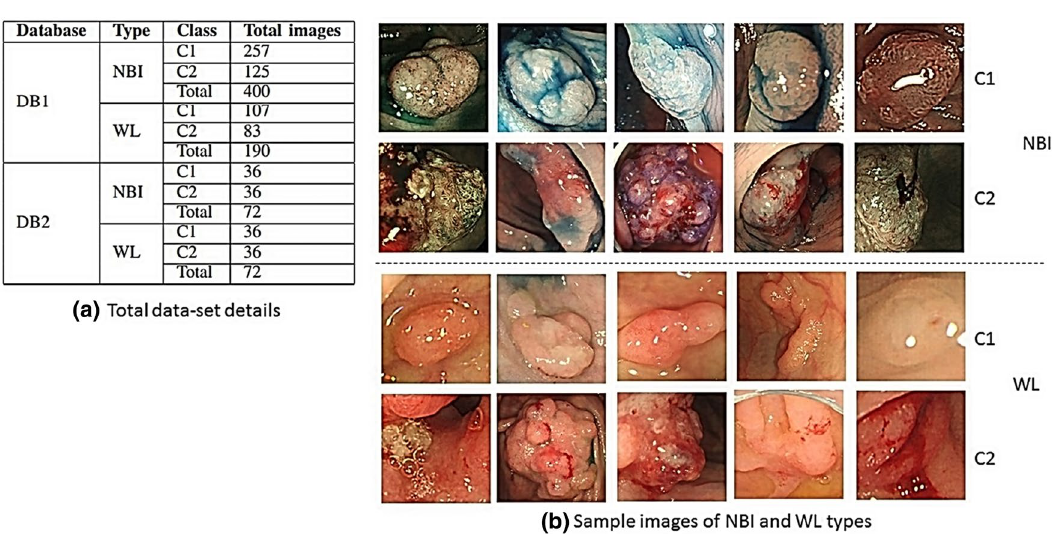
Figure 2. Dataset details with sample images, C1: non-neoplastic samples, C2: neoplastic samples. ( a ) Brief information (viz., type, sample class and total number of images for each sample class) of both the datasets, DB1 and DB2. ( b ) The sample images of NBI and WL types for dataset DB1. Interestingly, these images here are taken from own generated dataset DB1 obtained from Aichi Medical University, Japan [approved by